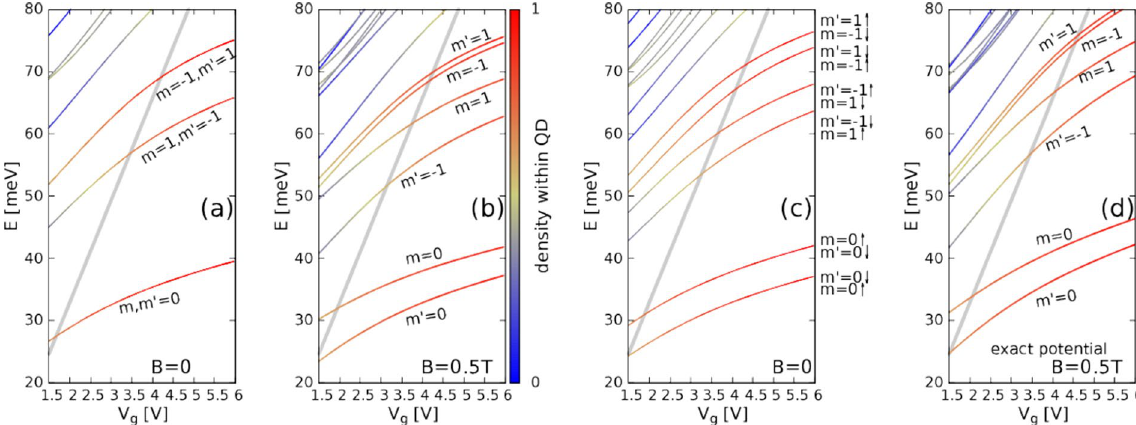
Figure 3. The solution of the Dirac equation for the quantum dot of radius R = 20 within a circular flake with R ’ = 40 nm and infinite mass boundary conditions at the flakes edge. The color of the lines shows the localization of the electron within 1.1 R from the center of the system and the scale is given to the right of ( b ). In the figure we mark the angular momentum quantum number for the A component, m for the energy levels belonging to the K valley and m ′ for the ones in K ′ valley. In ( a ) and ( b ) the spin-orbit coupling is absent, the applied magnetic fields are B = 0 ( a ) and B = 0.5 T ( b ). Plot ( b ) is a zoom of parameters of Fig. 2(b). In ( c ) B = 0 and the spin-orbit coupling is switched on. In ( c ) ↑ , ↓ stand for the z component of the spin. In ( a ) the energy levels are fourfold degenerate: with respect to the valley and the spin. In ( b ) the valley and spin degeneracy is lifted, but on the plot one resolves only the valley splitting, the Zeeman effect energy is too small to resolve the splitting of the lines. In ( d ) we plot the results obtained for the exact electrostatic potential of Fig. 1(b). Other plots ( a – c ) are obtained for the rectangular potential well of Eq. (1) as elsewhere in this